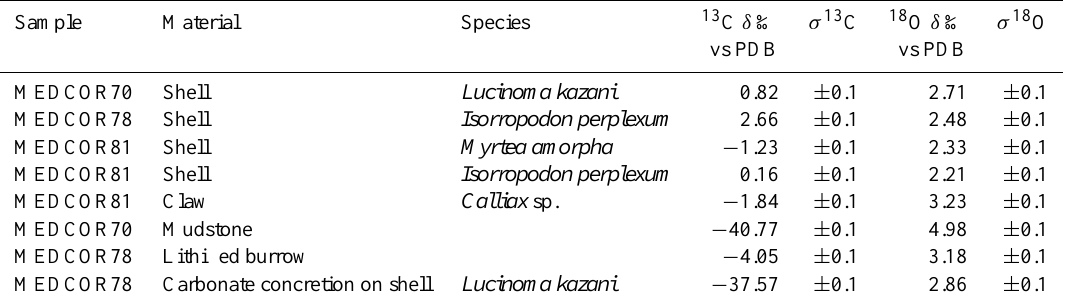
Table 2. Stable Isotopes Analysis expressed in the conventional δ notation relative to the Vienna-Pee Dee Belemnite (VPDB) reference standard.